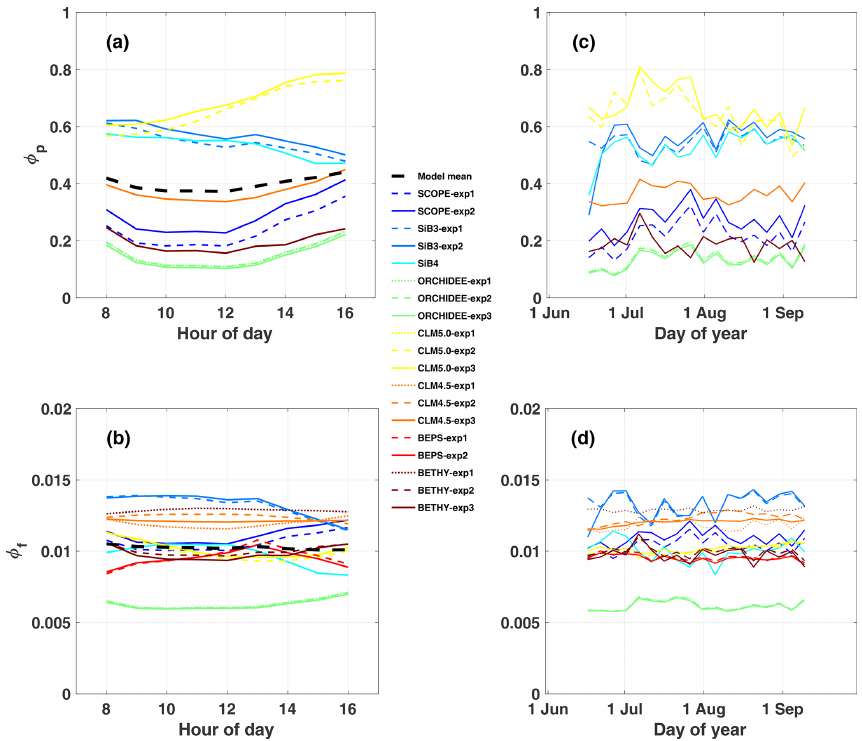
Figure 4. Same as Fig. 2, except for the quantum yield of fluorescence ( φ F ) and photochemistry ( φ P